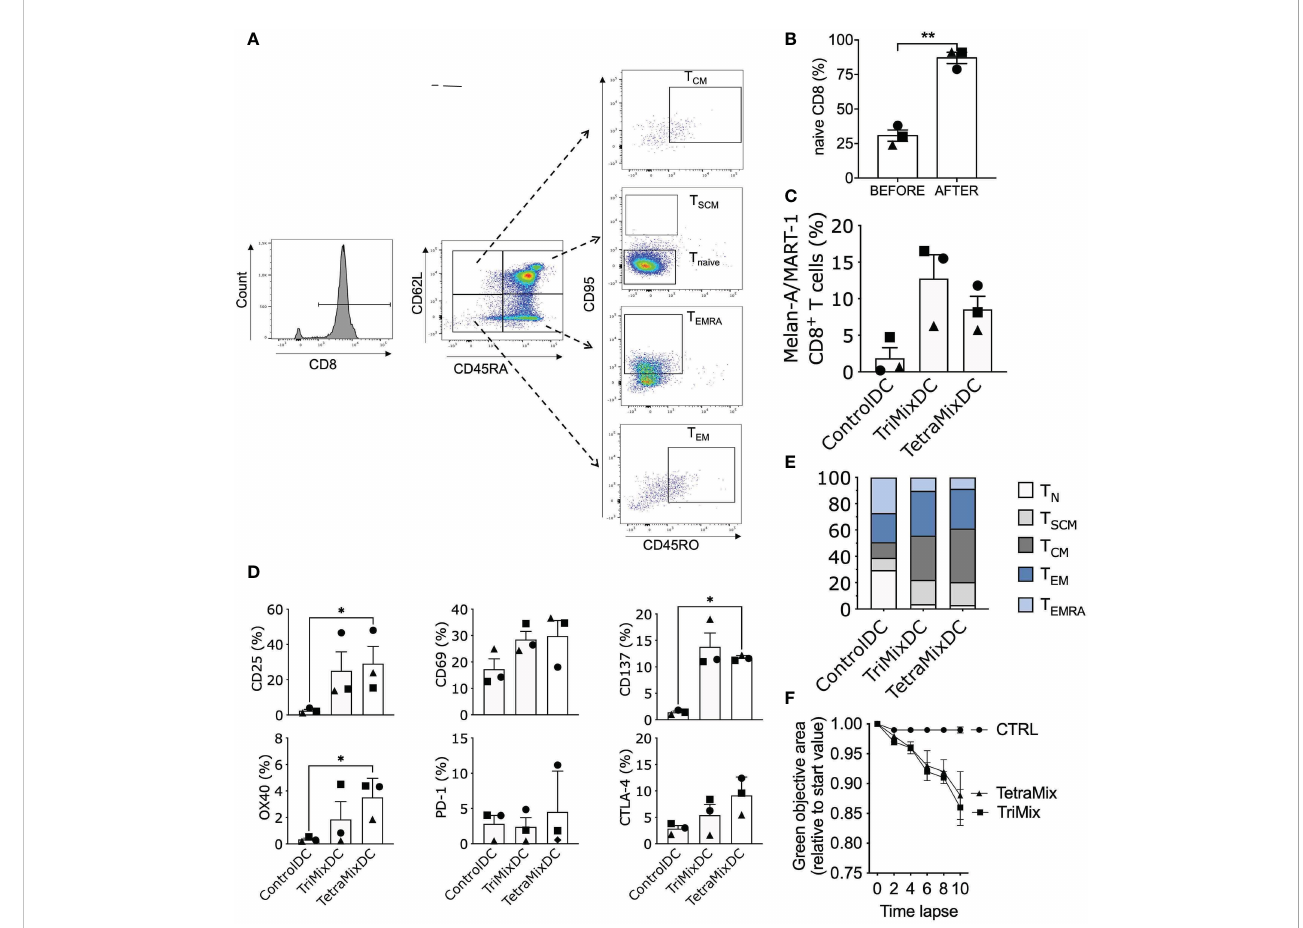
FIGURE 7 TetraMixDC stimulated naive T cells acquire an activated memory-like phenotype capable of inducing tumor cell death. DC co-electroporated with Melan-A/MART-1 mRNA and tNGFR (control), TriMix or TetraMix mRNA were co-cultured with sorted autologous naive CD8 + T cells (CD45RA + CD62L + CD45RO - CD95 - ). (A) Flow cytometry gating strategy for naive T cells (CD45RA + CD62L + CD45RO - CD95 - ), Stem cell-like memory (SCM) T cells (CD45RA + CD45RO - CD62L + CD95 + ), Central memory (CM) T cells (CD45RA - CD45RO + CD62L + CD95 + ), Effector memory (EM) T cells (CD45RA - CD45RO + CD62L - CD95 + ) and Effector memory re-expressing CD45RA (EMRA) T cells (CD45RA + CD45RO - CD62L - CD95 + ). (B) Bar graph showing the purity of naive CD8 + T cells: percentage of naive CD8 + T cell prior (left bar) and post (right bar) cell isolation. (C) Bar graph representing the percentage of Melan-A/MART-1-speci fi c CD8 + T cells at the end of the stimulation assay (21 days, weekly stimulation, total of 3 stimulation rounds). d) Bar graphs representing the percentage of activation markers on CD8 + T cells after the stimulation assay. Results in (B – D) are shown as mean value ± standard error of the mean for 3 independent experiments (n=3). Each symbol represents the data of an individual donor. Statistical signi fi cance is indicated as follows: *p < 0.05, **p < 0.01, by Friedman ’ s test. (E) Normalized stacked bar chart to visualize the partition of the different CD8 + T cell populations. (F) The ControlDC, TriMixDC and TetraMixDC stimulated T cells were added to 624-MEL GFP + cells that were grown in 3D tumor models. The green objective area, representing the viable tumor cells, was measured using the IncuCyte Zoom live cell imaging system. The decline in the green fl uorescent area relative to the start value is depicted for TetraMixDC, TriMixDC and ControlDC stimulated T cells conditions. Results are shown as mean value ± standard error of the mean for 2 independent experiments